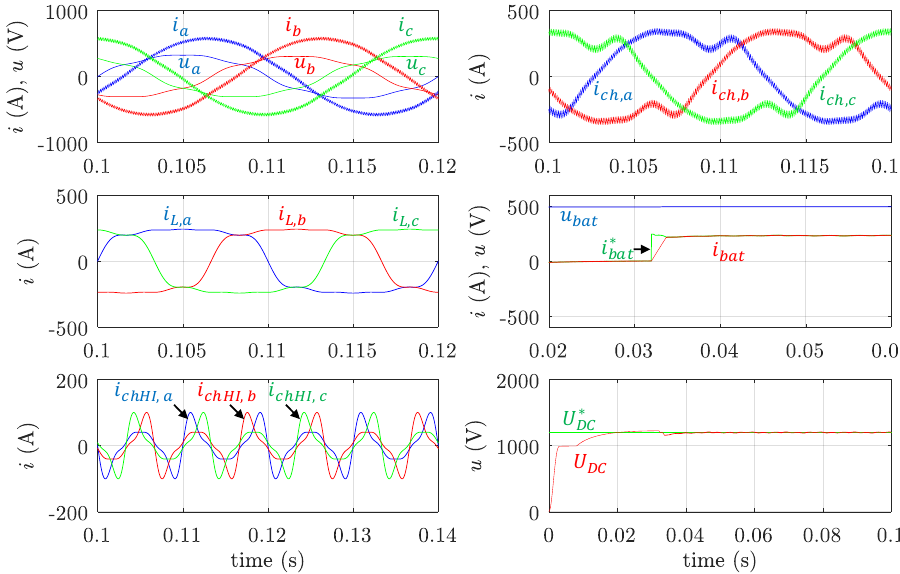
Figure 7. Simulation results. Case C. Charging the EV battery and demanding fundamental reactive power: P ∗ = 120 kW and Q 1∗ = – 120 kVAr. CS demand with harmonic content specified in Table 2. I L = 206.37 A. Table 5 . Load, grid, and charger current of the harmonic content for case C.